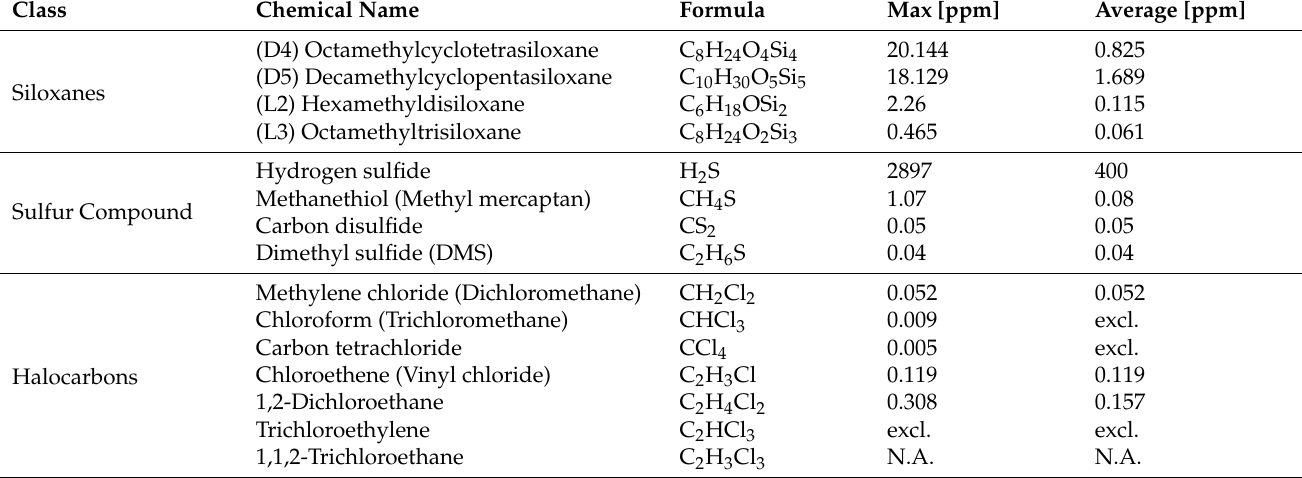
Table 2. List of trace compounds in biogas from Papadias et al. (based on the Argonne National Laboratory database). Adapted with permission from [37]; published by Elsevier,